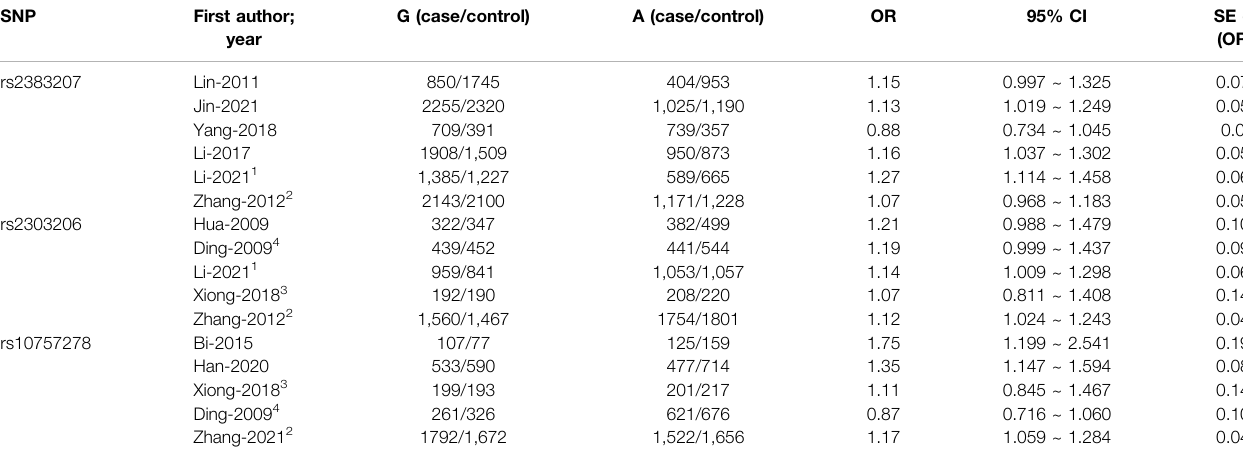
TABLE 2 | Correlation analysis between different genetic patterns of rs2383207, rs2383206, and rs10757278 at 9p21 locus and IS susceptibility.